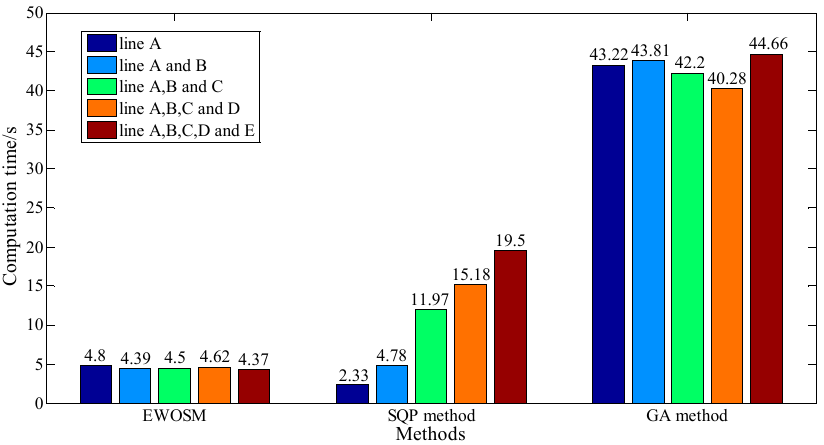
Figure 10. The comparison of computation time with three methods under different number of control variables. Table 6. The comparison of computation time with three methods varied with the number of control variables.